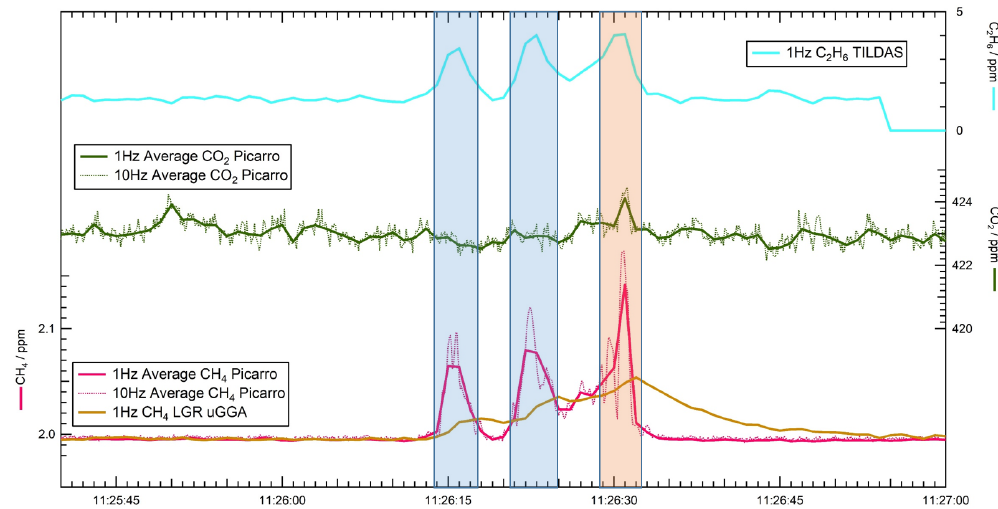
Figure 6. A cross section of CH 4 , CO 2 and C 2 H 6 measurement response during one plume sample as recorded by Picarro G2311-f in pink and green (10Hz as dashed lines and downsampled to 1Hz as solid lines), TILDAS 1Hz in cyan and Los Gatos uGGA 1Hz in brown. The difference between the uGGA and Picarro at 1Hz arises from the slower uGGA response time is due to the slower cell turnover. The blue-shaded area shows enhancement in C 2 H 6 and CH 4 , indicating cold venting; the orange-shaded area shows enhancement in C 2 H 6 , CH 4 and a small amount of CO 2 potentially indicating a co-located combustion source.